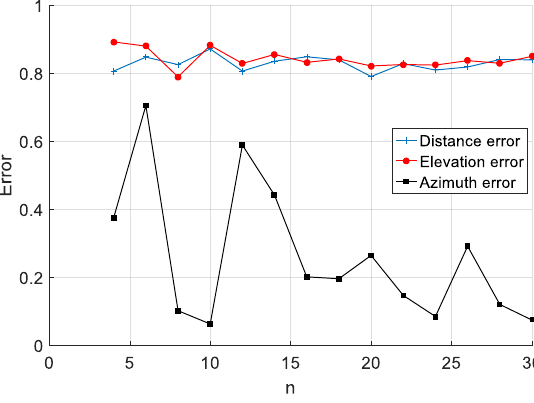
Figure 2. Relationship between number of sensors and localization error.